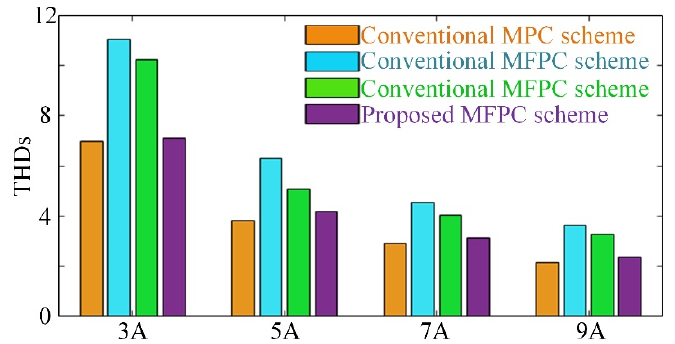
Figure 10. The comparison of phase-a current THDs under different reference currents.